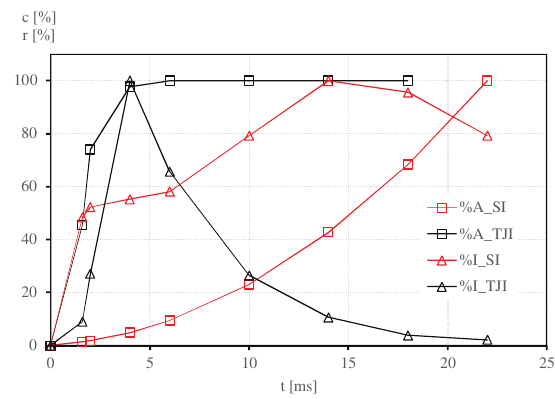
Fig. 4. Share of the flame (square points) and intensity (triangular points) in the optically accessible part of combustion chamber for SI (red line) and TJI (black line)